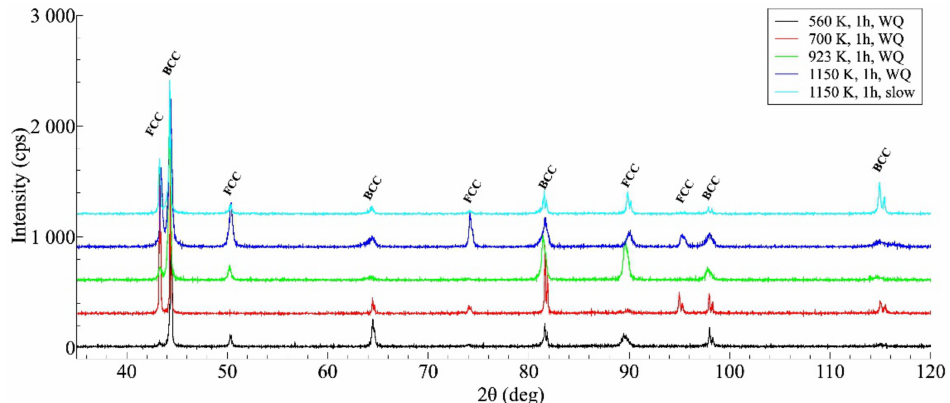
Figure 4. XRD profiles taken on the samples after different heat-treatments, showing the microstruc- ture having face-centered cubic (FCC)/ body-centered cubic (BCC) duplex after each heat treatment (the curves are shifted vertically by about 300 units from each other for a better view).